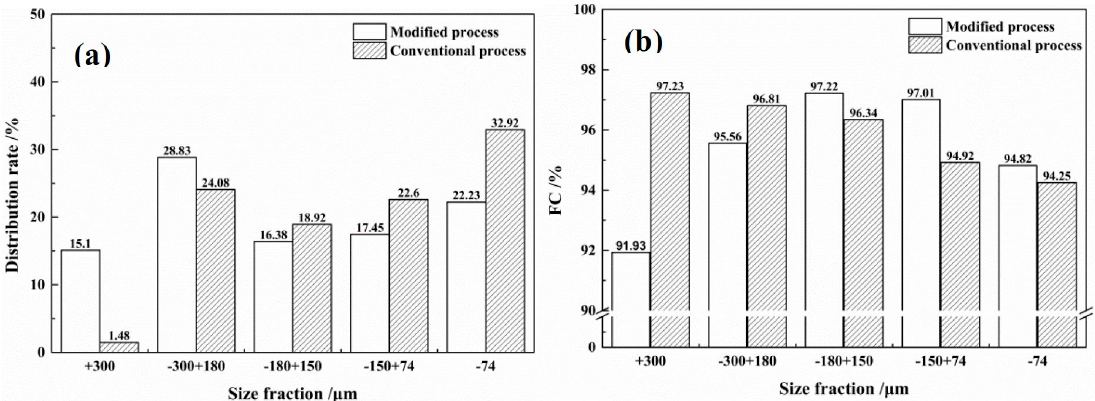
Figure 8. The size distribution rate ( a ) and the corresponding FC content ( b ) of concentrate by